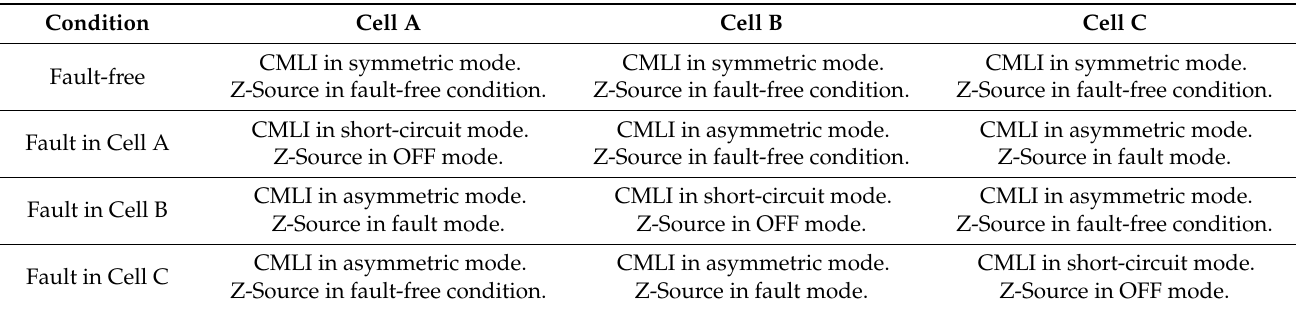
Table 1. Possible cases of CMLI with fault tolerance.